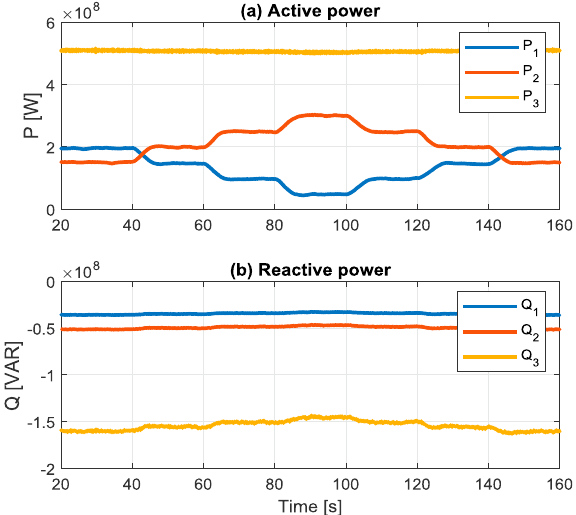
Figure 11. Power supplied by the individual PV generation units: ( a ) active power and ( b ) reac- tive power.